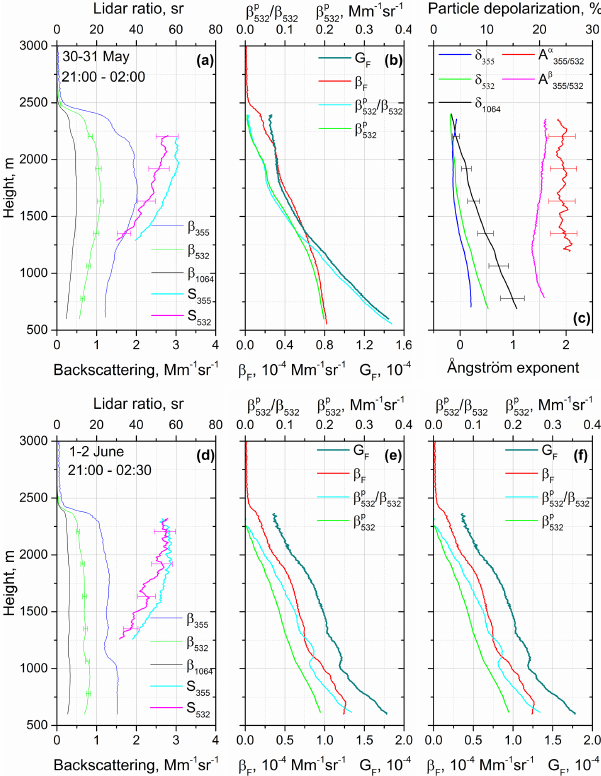
Figure 8. Vertical profiles of (a, d) particle backscattering coeffi- cients β 355 , β 532 and β 1064 as well as lidar ratios S 355 and S 532 . (b, e) Fluorescence backscattering coefficient β F , fluorescence ca- pacity G F , pollen backscattering coefficient β p and its contribu- 532 β p 532 . (c, f) Particle depolarization tion to the total backscattering β 532 ratios δ 355 , δ 532 and δ 1064 together with extinction A α and 355 / 532 backscattering A β Ångström exponents on (a–c) 30–31 May 355 / 532 β p 532 02:30UTC. Profiles of β p and were computed with the as- β 532 532 = 30%. The depolarization ratios of the back- sumption that δ p 532 ground aerosol δ b are measured or assumed to be 3% on 30 May 532 and 5% on 1